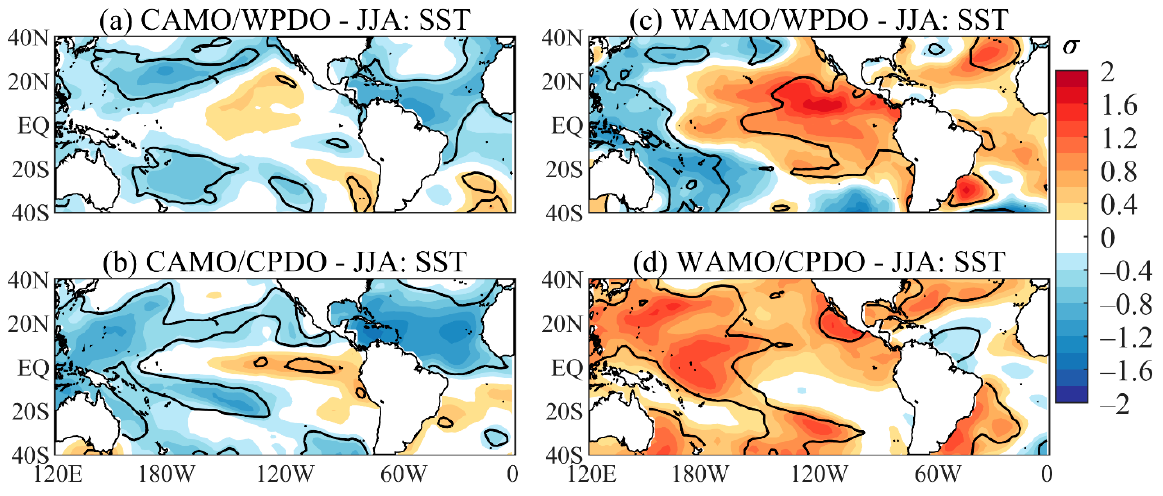
Figure 7. June–August SST standardized anomalies during intense CLLJ events of the: ( a )CAMO/WPDO; ( b )CAMO/CPDO; ( c )WAMO/WPDO; and ( d )WAMO/CPDO mean states. Display is same as Figure 4.